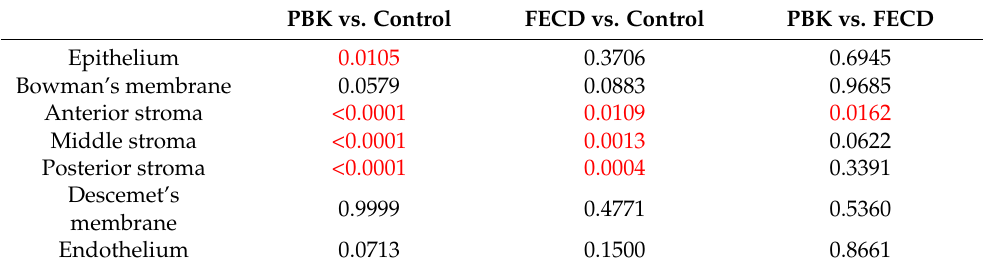
Table 4. Comparison of tenascin-C expression in the different corneal layers in normal and diseased groups. PBK vs. Control FECD vs. Control PBK vs. FECD Epithelium 0.0105 0.3706 0.6945 Bowman’s membrane 0.0579 0.0883 0.9685 Anterior stroma <0.0001 0.0109 0.0162 Middle stroma <0.0001 0.0013 0.0622 Posterior stroma <0.0001 0.0004 0.3391 Descemet’s 0.9999 membrane